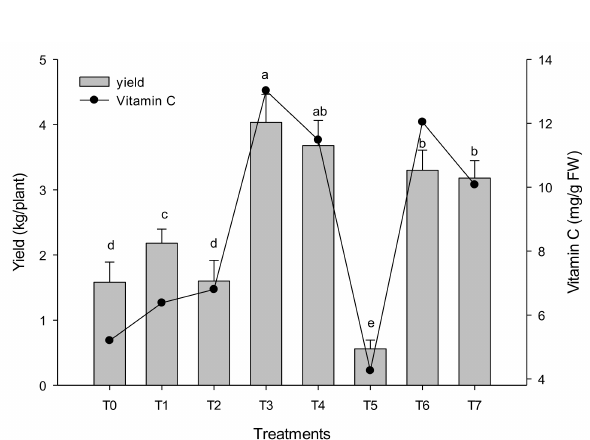
Figure 7. Effect of SWE on mitigating salt stress effects on fruit yield (kg/plant) and Vitamin C (mg/g FW). Mean ( ± SEM) of 5 replicates. Within each time point, the same letter indicates no significant difference ( p ≤ 0.05) in a Tukey’s test. (T0—Control, T1—NC, T2—NC + S150 mM, T3—PC, T4—PC + S150 mM, T5—S150 mM, T6—SWE 80%, T7—T5 +